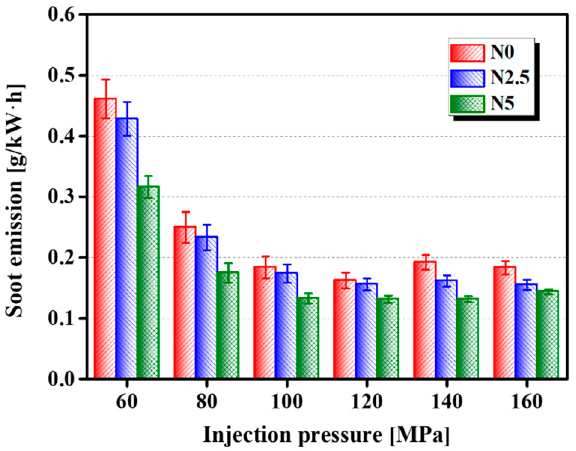
Figure 12. Soot emissions of different injection pressures for n -octanol/diesel blends.